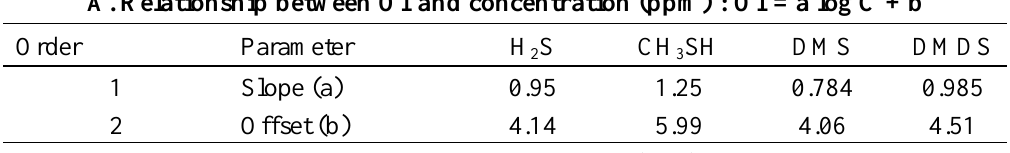
Table 1. Preparation of RSC standard for air dilution sensory (ADS)